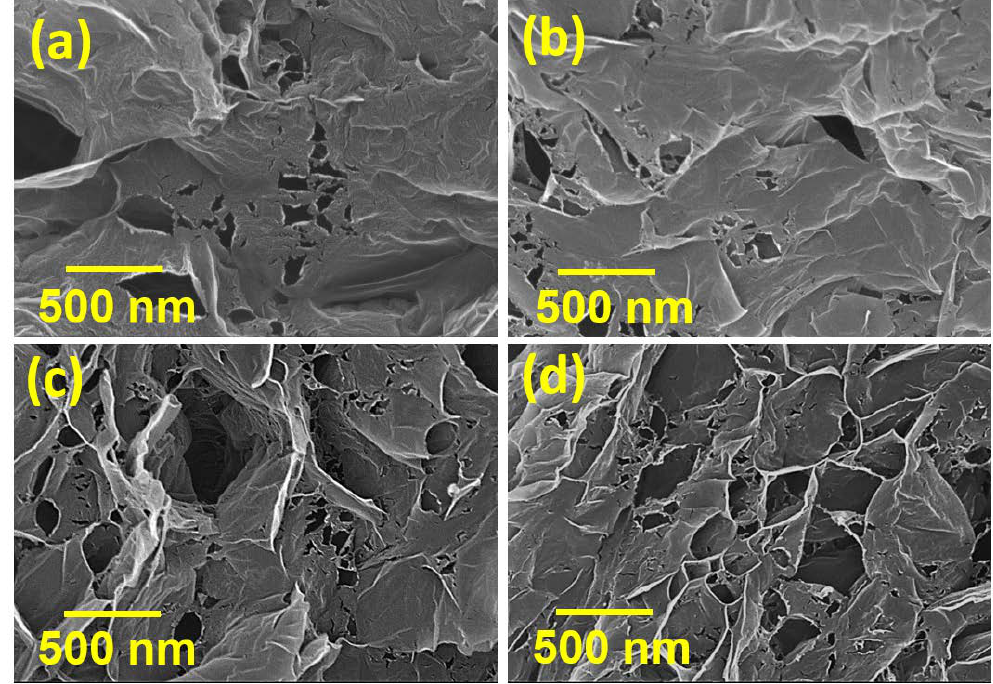
Figure 1. SEM micrographs of ( a ) HGNS-300; ( b ) HGNS-700; ( c ) HGNS-900; and ( d ) HGNS-1100 samples.